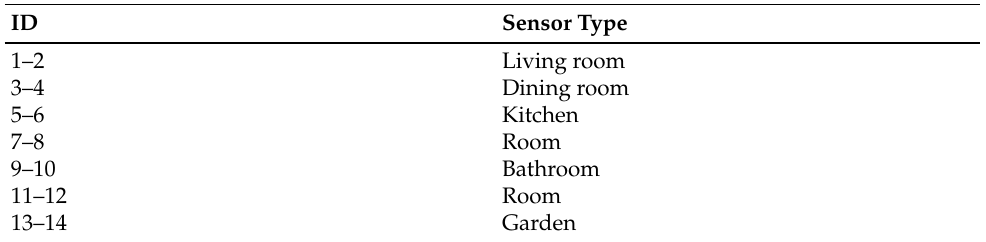
Table 2. Distribution of node devices in areas of house. These nodes can have one or more sensors connected to